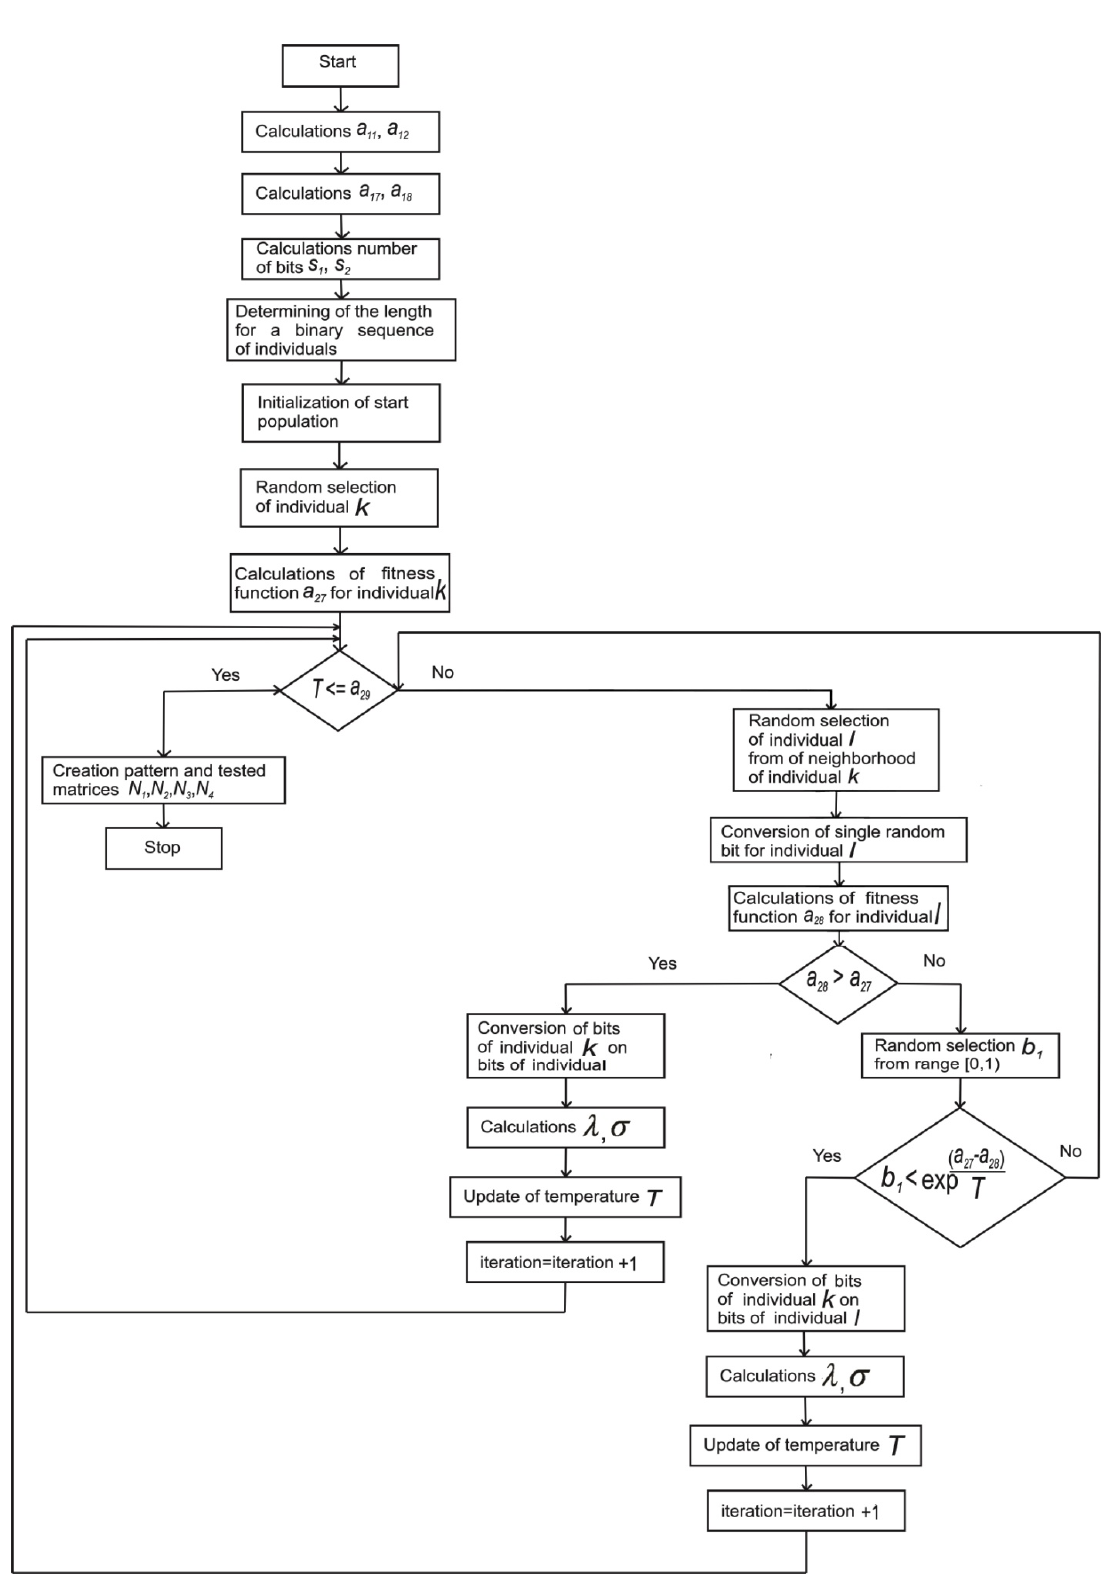
Figure 3. Block diagram of genetic algorithm with simulated annealing operation.